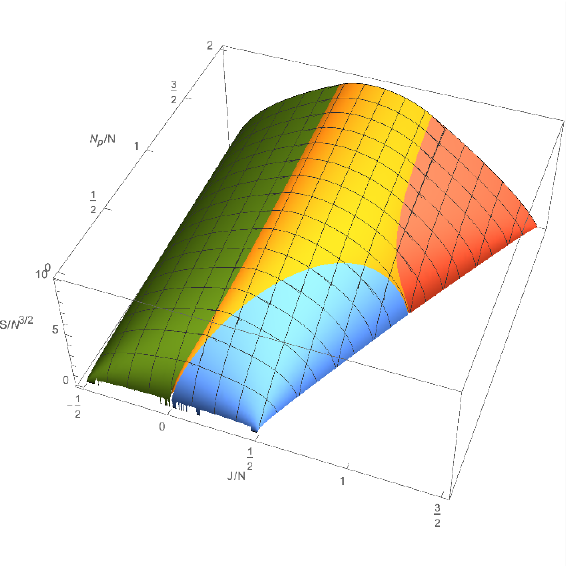
Figure 6 . The phase diagram on the J - N p plane. N p = L 0 (cid:0) N condensation happens and the entropy is given by (4.77). In region I (light blue shaded), condensate of j + i forms and (cid:1) (1) > 0. In region II (light green shaded), condensate of j(cid:0)i 1 In region III (light red shaded), condensate of ( J + black line N p = J 2 , single-center black holes exist. The purple solid lines represent the unitarity bound below which no states exist.